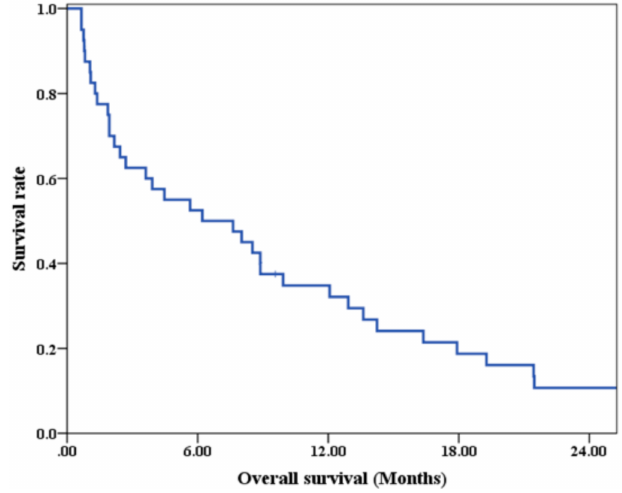
Figure 1. Overall survival of all non-elderly brain metastases patients.